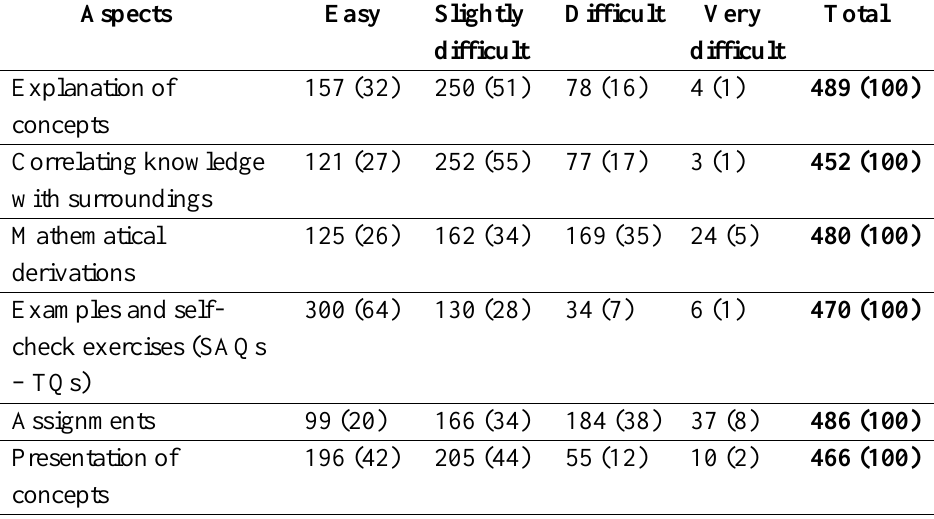
Table 4 Learner Rating of Difficulty Level of